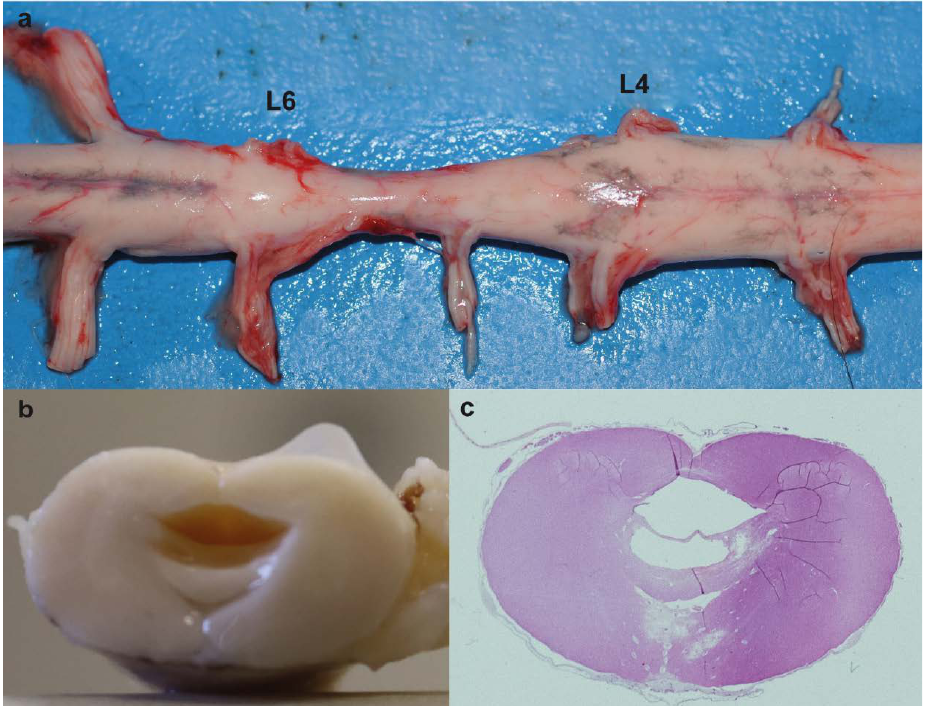
Figure 2. Myelodysplasia associated with hydrosyringomyelia in the affected calf. ( a ) Note the narrowing of the spinal cord between lumbar spinal nerves IV (L4) and VI (L6) (myelodysplasia). ( b ) Transversal section of the spinal cord between lumbar spinal nerve V (L5) and VI (L6). Note the cavity formed within the spinal cord. ( c ) Histological section of ( b ). Note that there are two cavities with only the larger partially lined by ependymal cells (hydrosyringomielia). hematoxylin and eosin (H&E) staining.